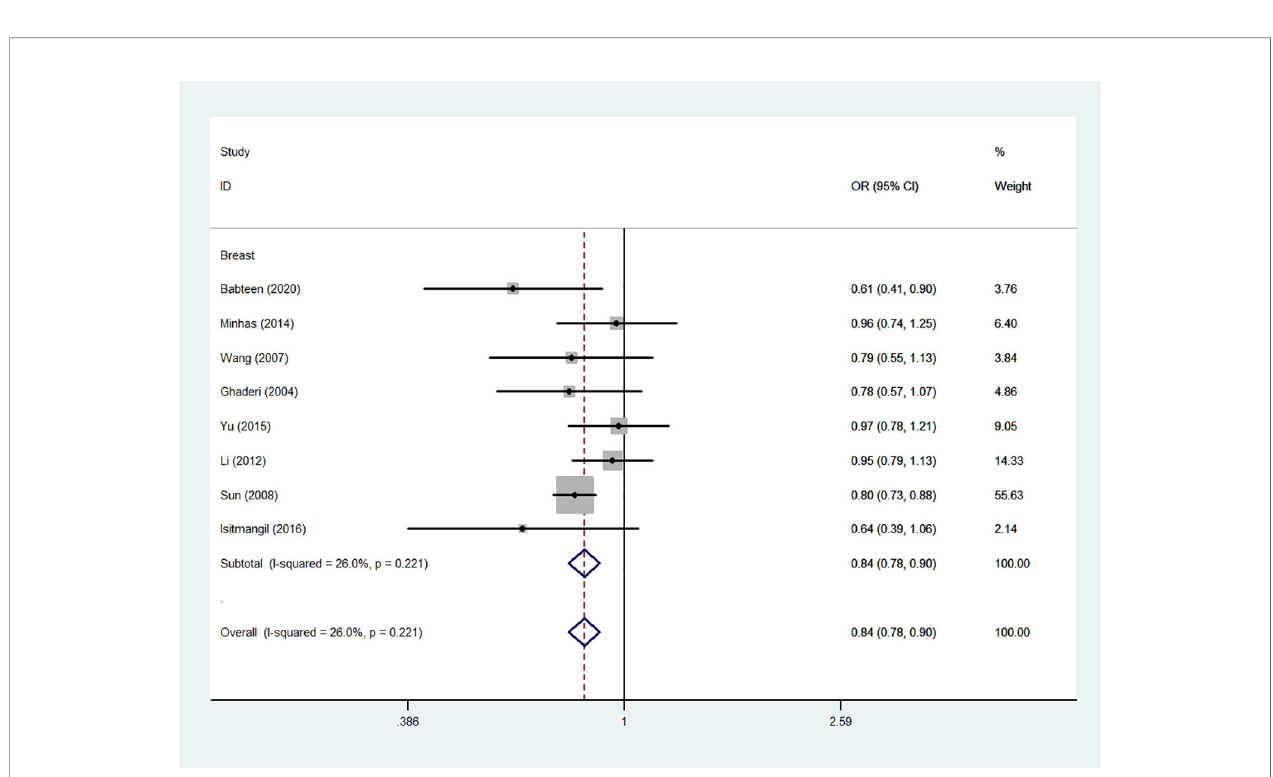
FIGURE 5 | Forest plot of the association between the CTLA-4 gene rs231775 polymorphism and breast cancer risk (G-allele vs. A-allele).